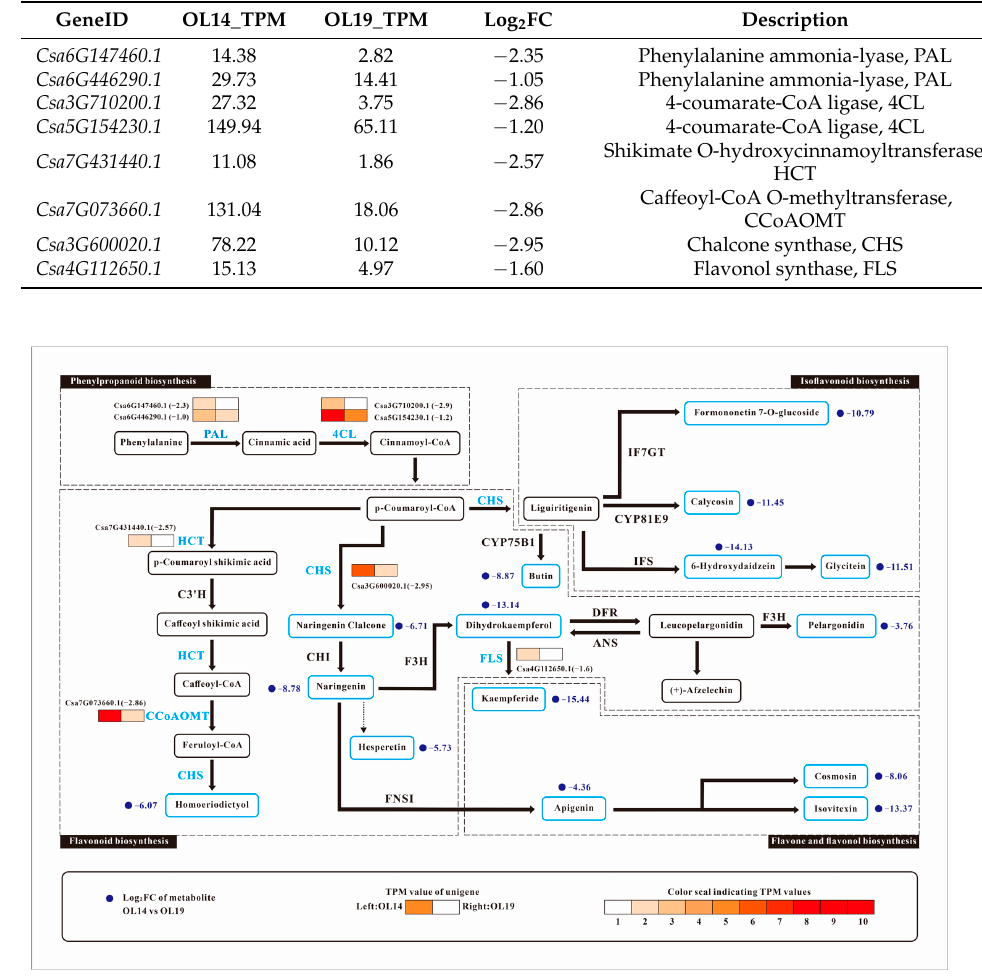
Figure 5. OL14_vs_OL19 changes in the expression of phenylpropionic acid, flavonoids, isoflavones, flavonoid and flavo- nol biosynthesis pathway genes and metabolites. OL14 and OL19 are old cucumber fruits. OL14, peel is yellow; OL19, peel is white. TPM: transcripts per million. Table 2. Differential expression genes (DEGs) related to peel yellowing in OL14_vs_OL19.